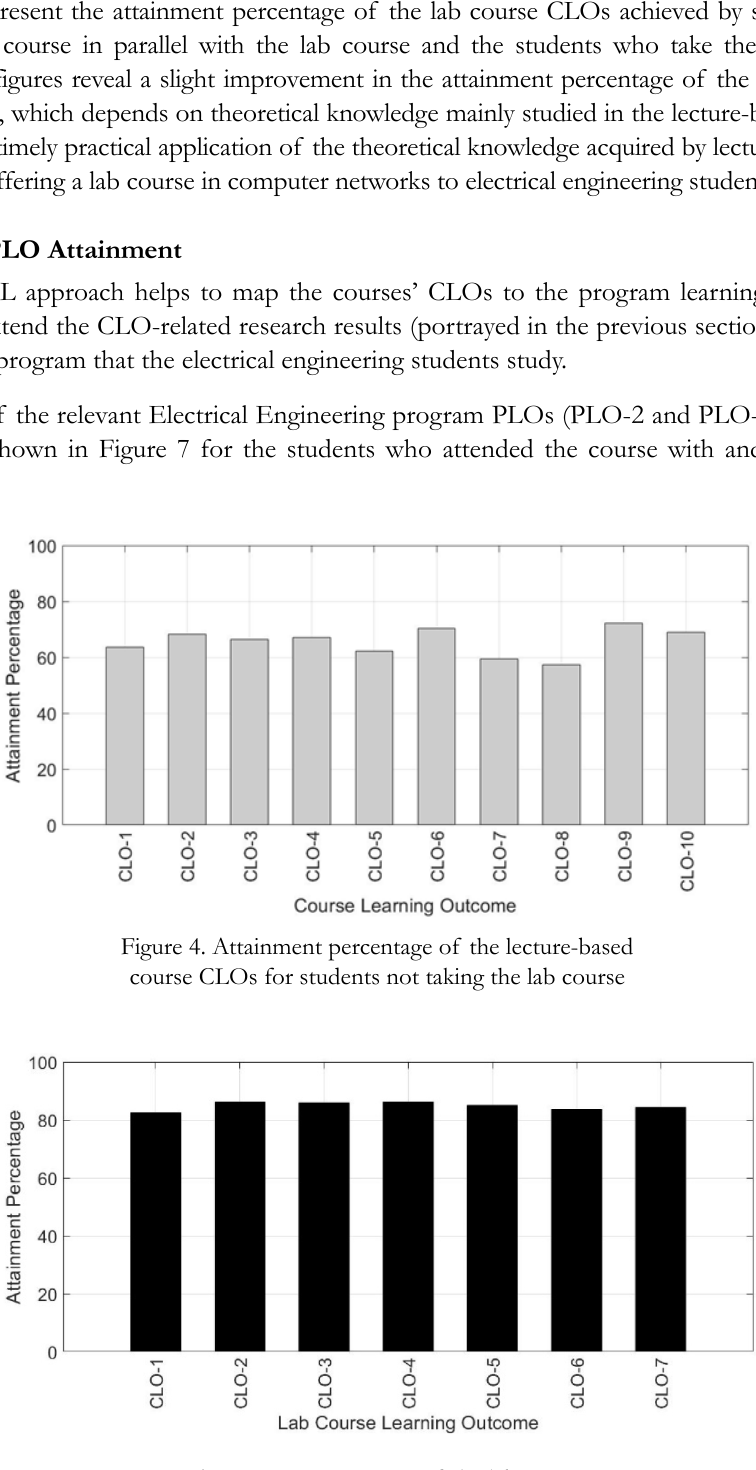
Figure 5. Attainment percentage of the lab course